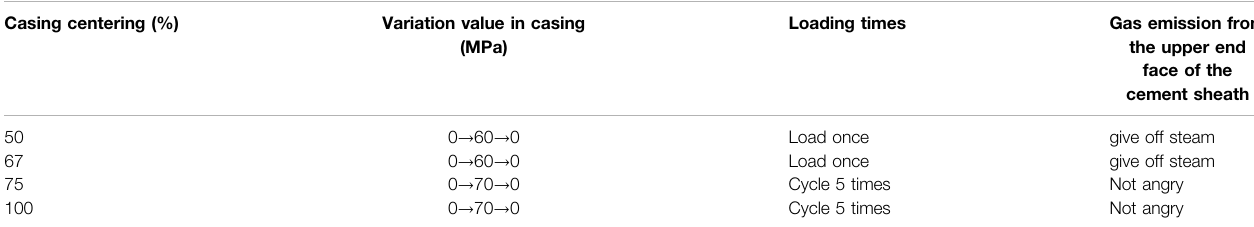
TABLE 5 | Experimental results of the in fl uence of casing internal pressure on sealing integrity under the casing eccentricity. Casing centering